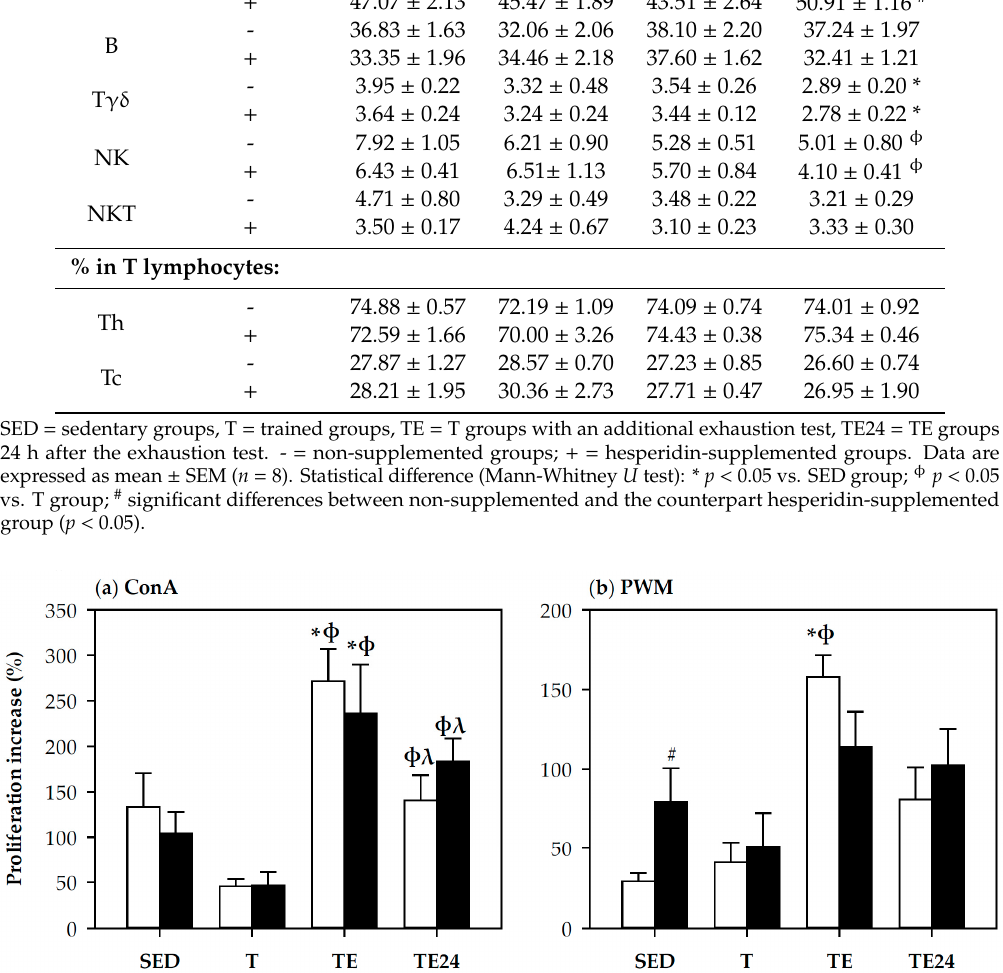
B cell proliferative capacity increased after exhaustion in non-supplemented animals ( p = 0.009,